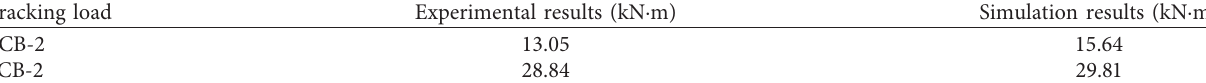
Table 10: Cracking loads of the two-span continuous composite T-shaped beams.